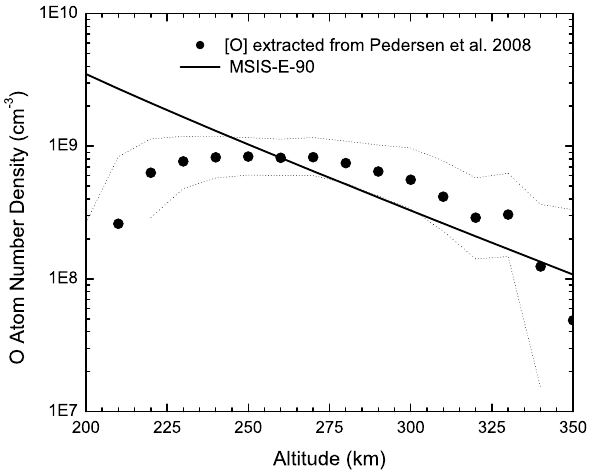
Fig. 3. O-atom number density as a function of altitude, determined from the observations by Pedersen et al. (2008) at HAARP. The dashed line reflects the reported lifetime uncertainty and the thick solid line represents the MSIS-E-90 atmospheric